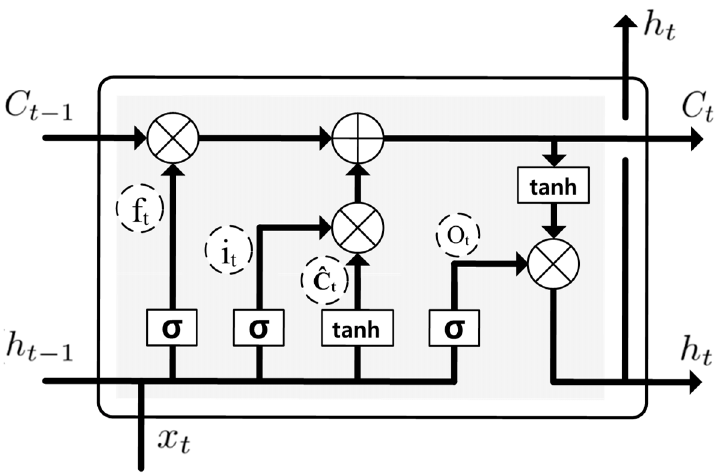
Figure 1. Inner structure of long short-term memory